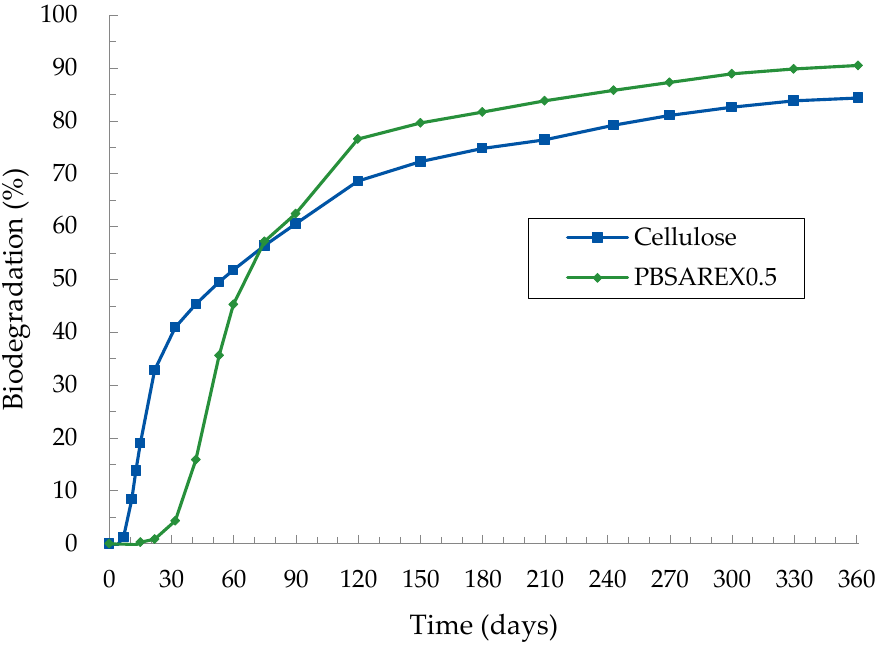
Figure 3. Biodegradation curve in soil conditions according to ISO 17556.